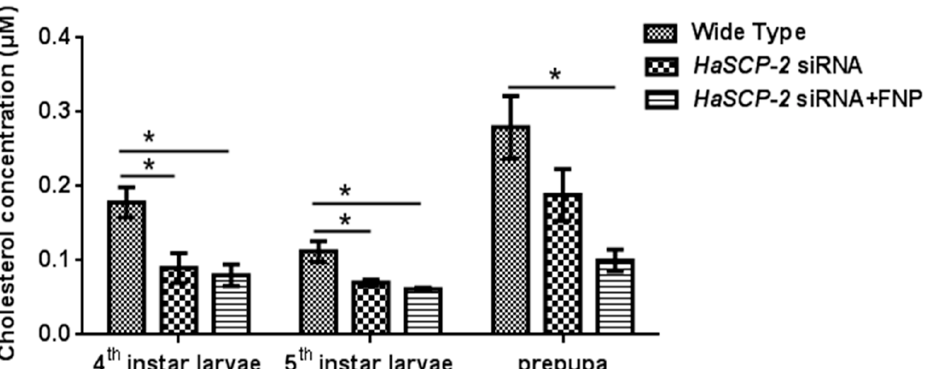
Figure 7. Cholesterol level in the fatbody. To study the effect of HaSCP-2 knockdown on cholesterol accumulation by FNP-RNAi, ten 2nd instar larvae were synchronized as a group and fed with FNP-HaSCP-2 siRNA ( HaSCP-2 siRNA + FNP group). Fatbody tissues from 3rd, 4th, and 5th instar larvae, respectively, were collected (five individuals/sample), and used for the cholesterol level assay. The 2nd instar larvae that fed with HaSCP-2 siRNA and DEPC -treated ddH 2 O (Wild Type group), respectively, were set as the control. Data are mean ± SD. Asterisk “*” indicates significance at p < 0.05 level.